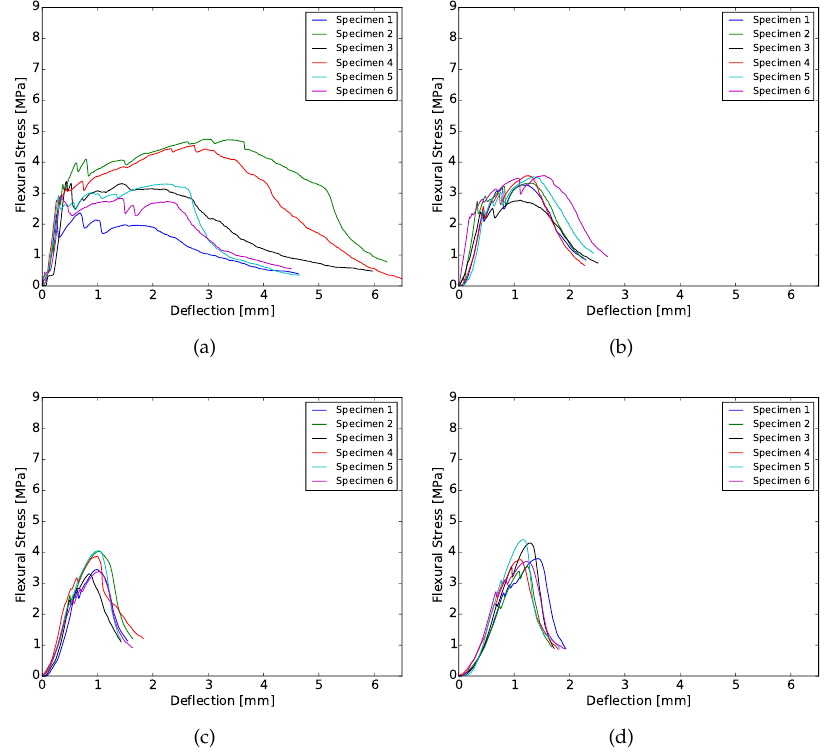
Figure 5. Flexural hardening behavior for YVA4PVA20-S05 samples samples cured for 28 days. ( a ) 1 layer; ( b ) 2 layers; ( c ) 3 layers; ( d ) 4